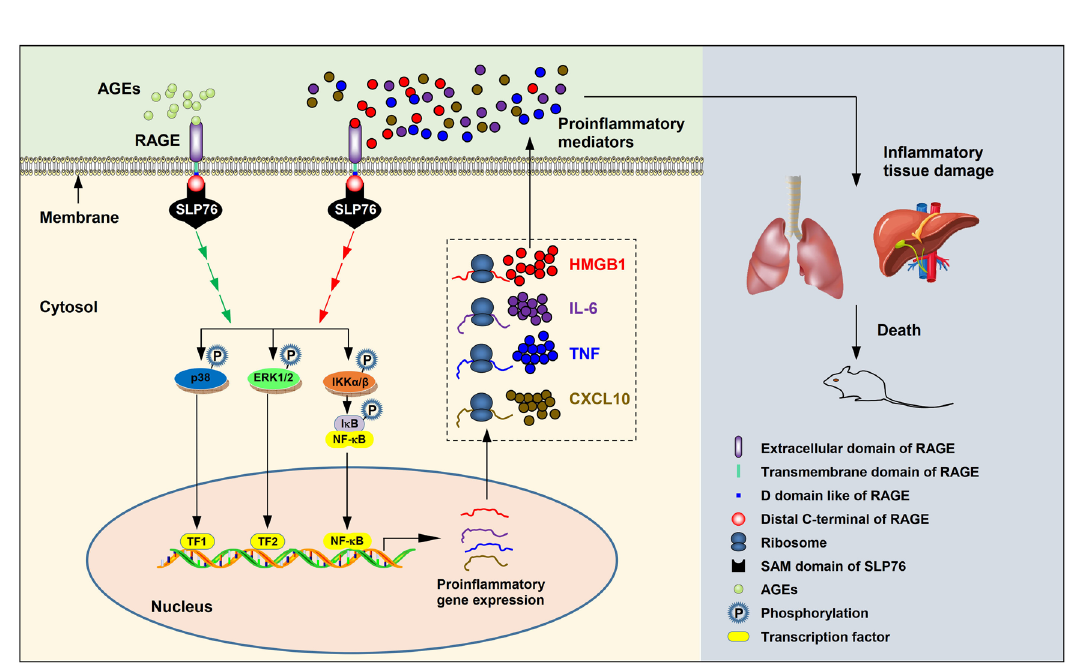
Fig. 7 Pivotal function of SLP76 in RAGE-mediated intracellular signaling in sepsis. At the onset of sepsis, AGEs are rapidly released and accumulate in the blood. After binding of AGEs with the cell surface receptor RAGE, SLP76 is recruited to the cytosolic tail of RAGE as an adaptor protein to transduce signals from the membrane into the cell, resulting in rapid activation of the p38 MAPK, Erk1/2, and IKK α / β pathways via sequential protein phosphorylation. Activation of downstream kinases results in phosphorylation of transcription factors (TFs) such as NF- κ B, thus enhancing the gene transcription of proin fl ammatory mediators, including TNF, IL-6, CXCL10, HMGB1, etc. The DAMP molecule HMGB1 acts on RAGE, initiating the second wave of protein kinase cascade activation, which generating a positive feedback mechanism to maintain and amplify the proin fl ammatory response. Overproduction of proin fl ammatory factors causes tissue damage and fi nally leads to multiple organ failure and death in